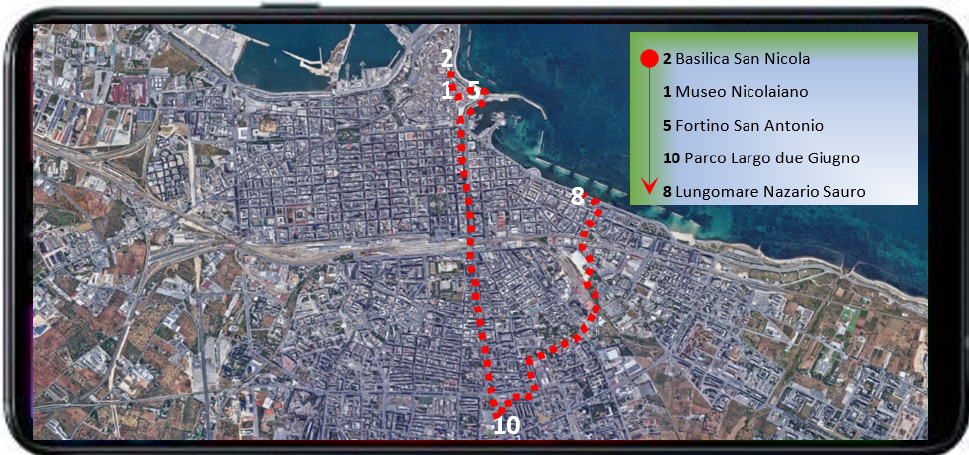
Figure 20. The GUI of the outward